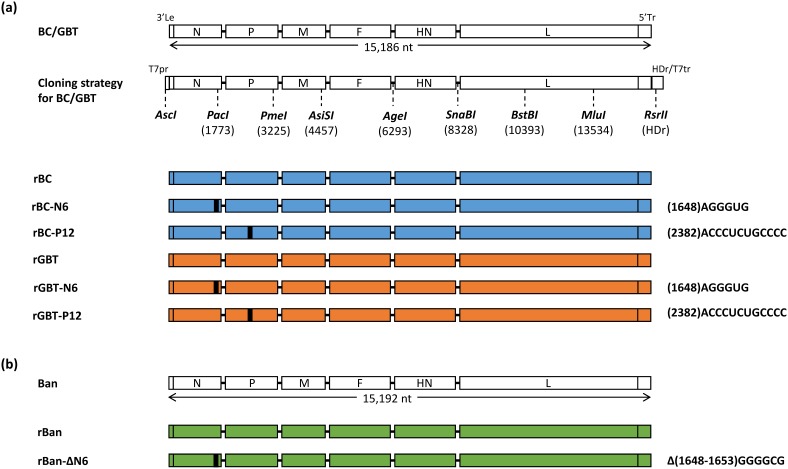
Gene map, reverse genetic cloning strategy for NDV strains Beaudette C, GB Texas and Banjarmasin.(a) Gene map and cloning strategy for NDV strains BC and GBT and their mutant viruses. Top two schematic gene maps show genetic structure, genome-length and cloning strategy for NDV strains BC and GBT. The location of RE sites in the antigenome cDNA clones of strains BC and GBT are shown. The numerals indicate genome nt position. AscI and RsrII sites are present before T7 promoter (T7pr) sequence and within hepatitis delta virus ribozyme/T7 terminator (HDr/T7tr) sequence, respectively, in the plasmid vector pBR322 (see Materials and Methods section). Bottom six gene maps illustrate the recombinant, 6-nt and 12-nt insert mutant viruses. The diagrams of N and P gene boxes show the position (indicated by a small box in black) of the 6-nt and 12-nt inserts in rBC and rGBT to generate mutant viruses rGBT-N6 and rBC-N6 (genome lengths of 15,192 nt) and rGBT-P12 and rBC-P12 (genome lengths of 15,198 nt). The nt position and sequence of the insert is given on the left. (b) Gene map of recombinant and 6-nt deletion mutant of NDV strain Ban. The recombinant and the 6-nt deleted viruses are indicated by rBan and rBan-ΔN6, respectively. The deleted 6-nt sequence and the nt position (indicated by a small box in black) in the 15,192-nt genome of Ban is provided on the left. Le and Tr indicate leader and trailer regions, respectively.